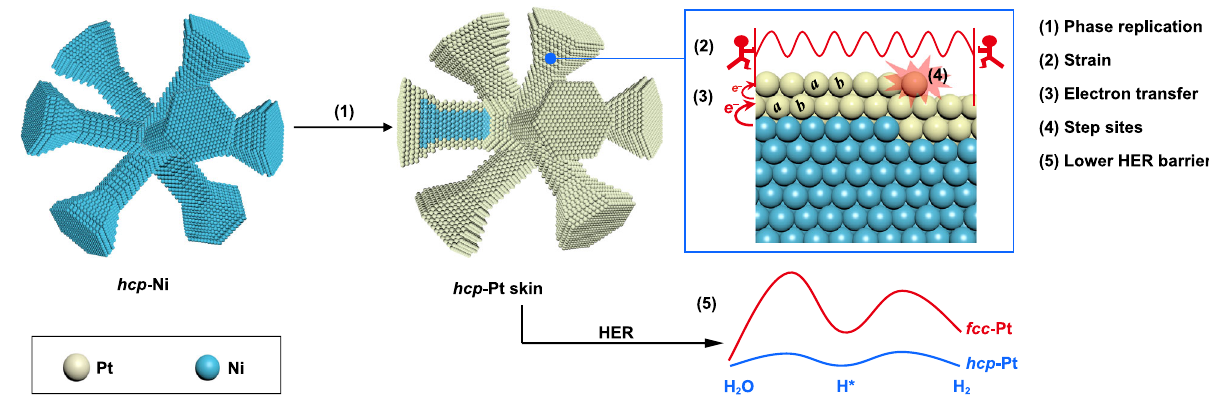
Fig. 1 | Synthesis and electronic interactions of a coherent metastable hcp -Pt skinonan hcp -NinanocrystalfortheHER. AcoherentPtskinisgrownonan hcp - Ninanocrystalbysuppressingthegalvanicreplacementreaction,leadingtoaphase